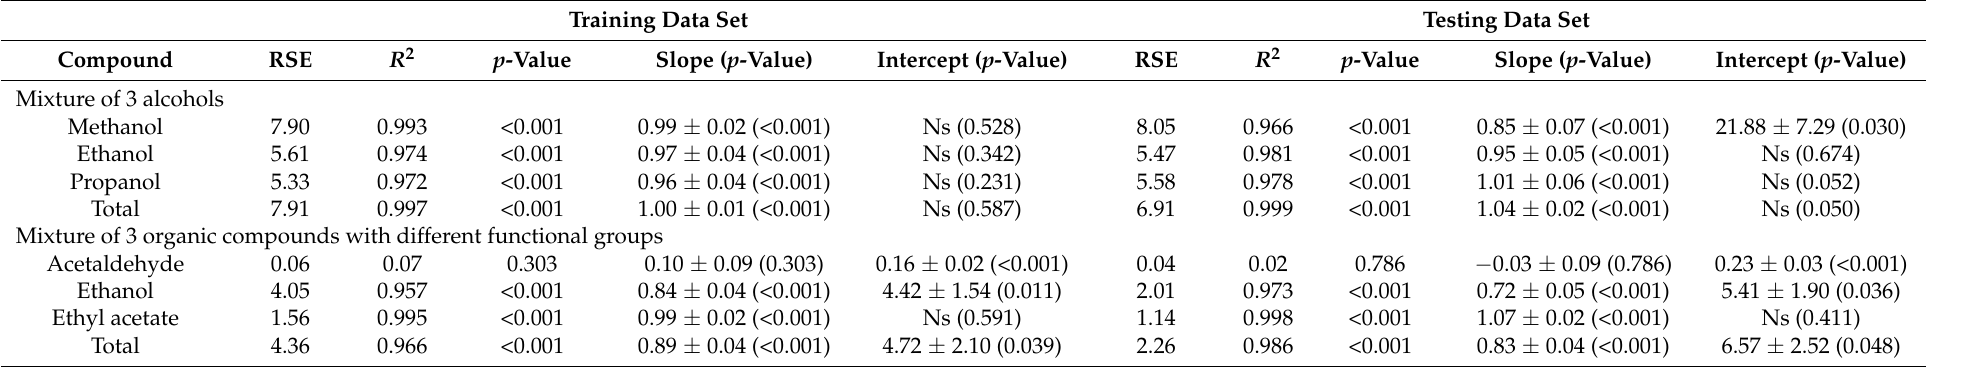
Table 5. Parameters of the linear regression model established between the predicted model and real values for training and testing data